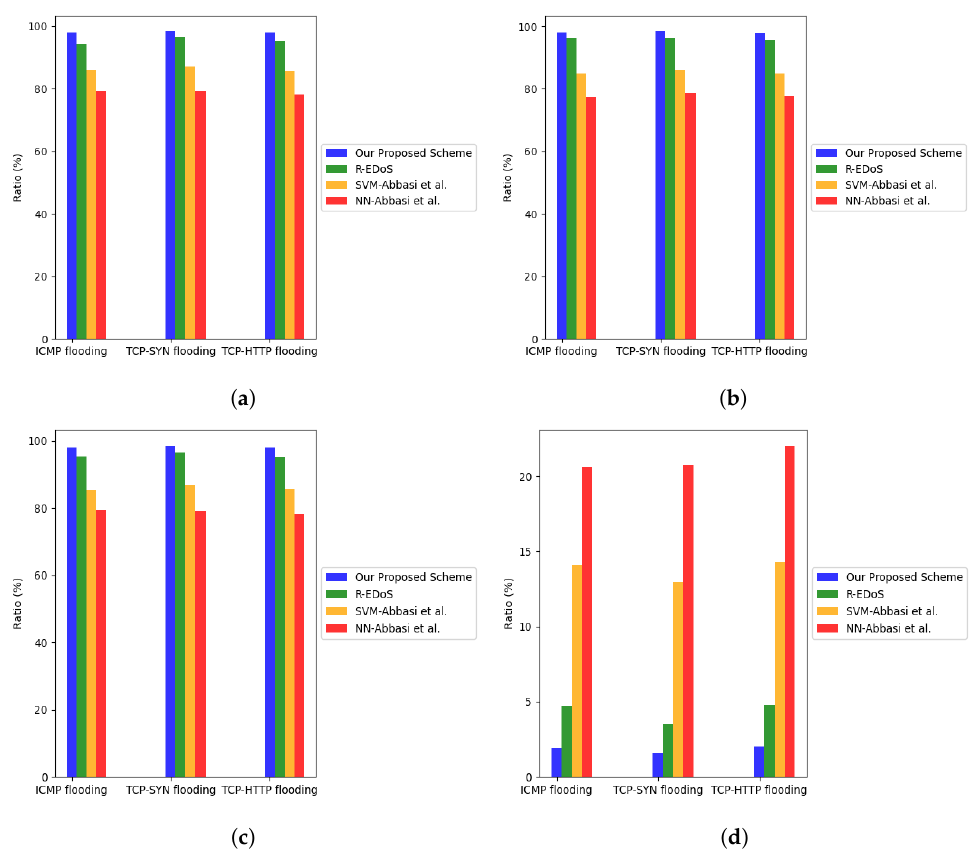
Figure 9. Detection performance comparison of the flow detector in different kinds of EDoS attacks.